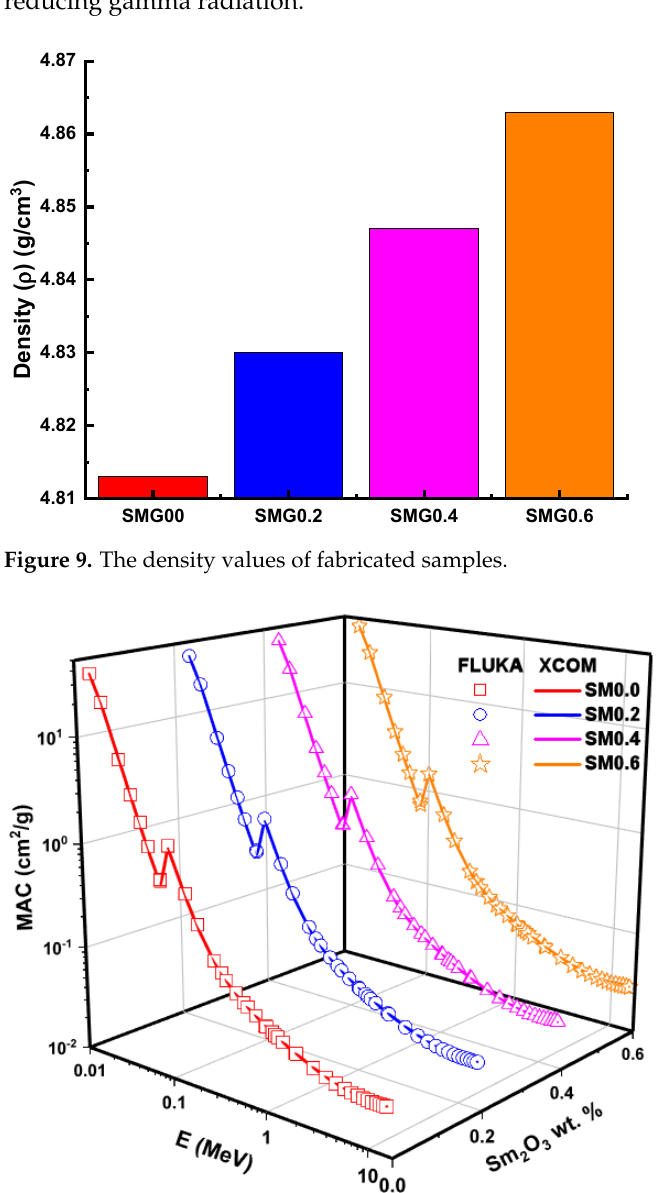
Figure 11. The relative difference of mass attenuation coefficient by XCOM and FLUKA simulation.